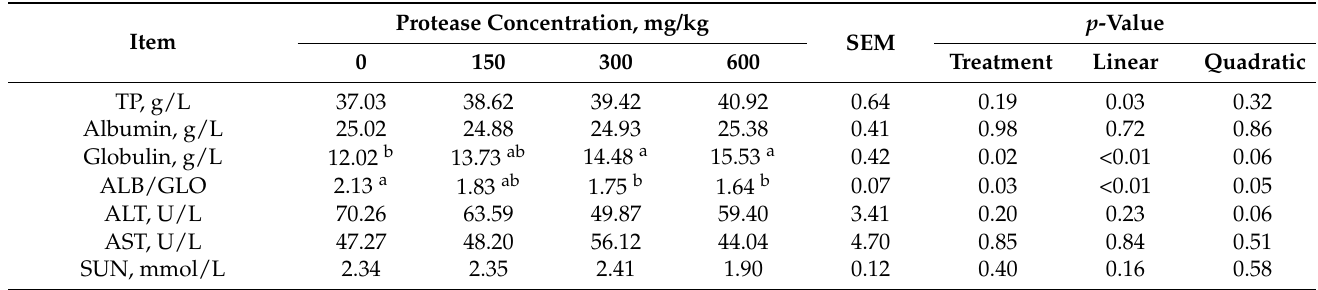
Table 7. Effects of protease supplementation on blood metabolites in weaned piglets.